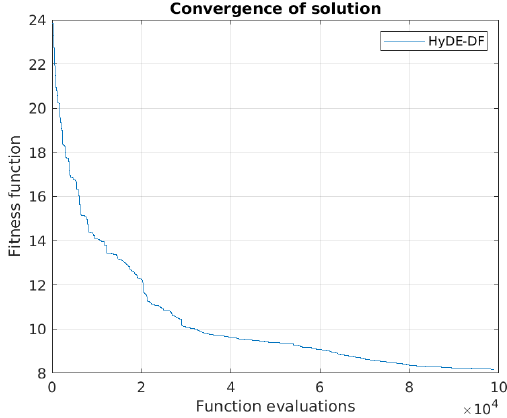
Figure 6. HyDE-DF, 10 5 func. evaluations: 92.442 s optimization value = 8.1763.